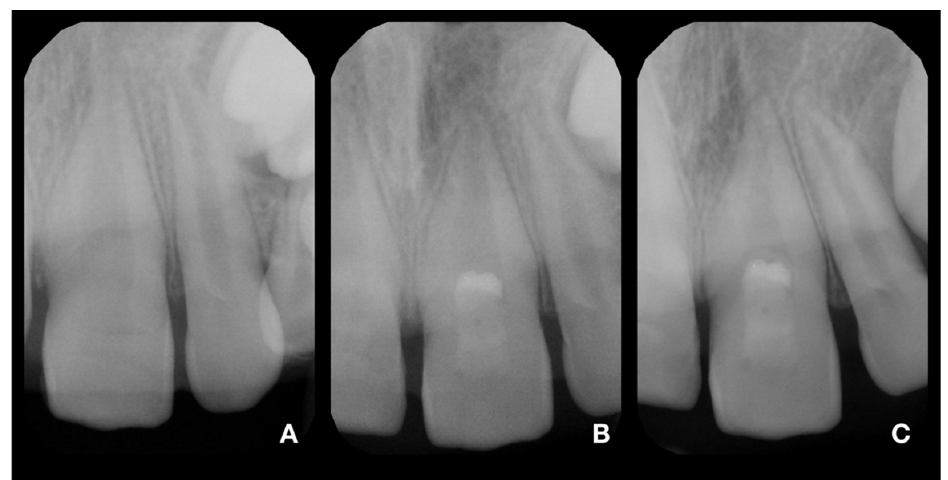
Figure 3. X-rays of tooth 21. ( A )—diagnostic X-ray of tooth 21; ( B )—postoperative X-ray of tooth 21; ( C )—control X-ray at 24-month follow-up. The continuing development of the root and narrowing of the root canal is visible. In addition, the formation of a radiopaque bridge under the calcium silicate cement and the absence of periapical radiolucency are apparent.